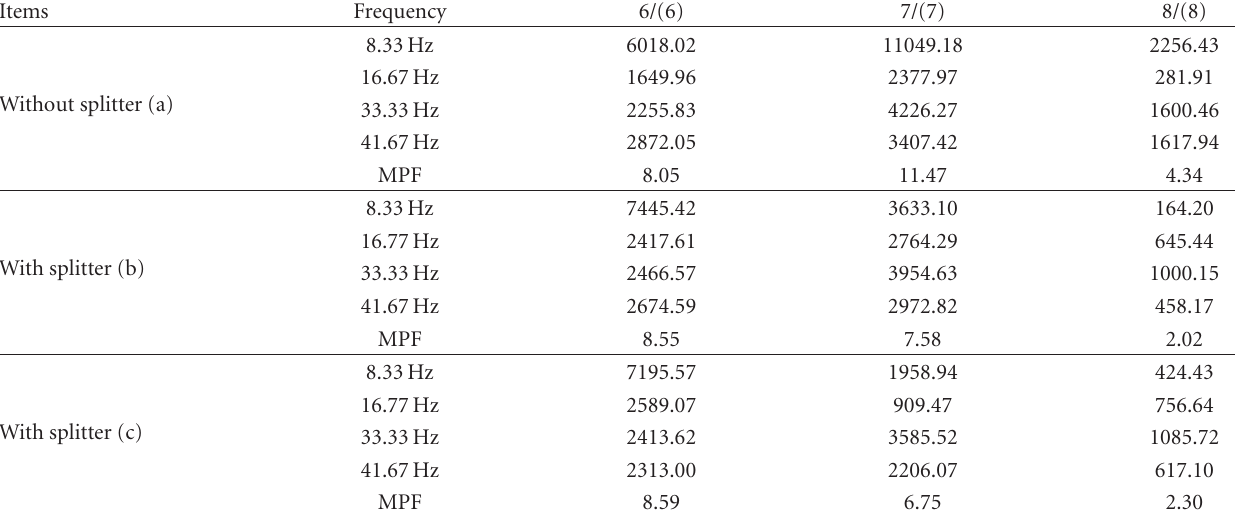
Table 4: Amplitude of frequency domain and MPF at impeller monitoring points (see Figures 9(a), 9(b), and 9(c)). Items Frequency